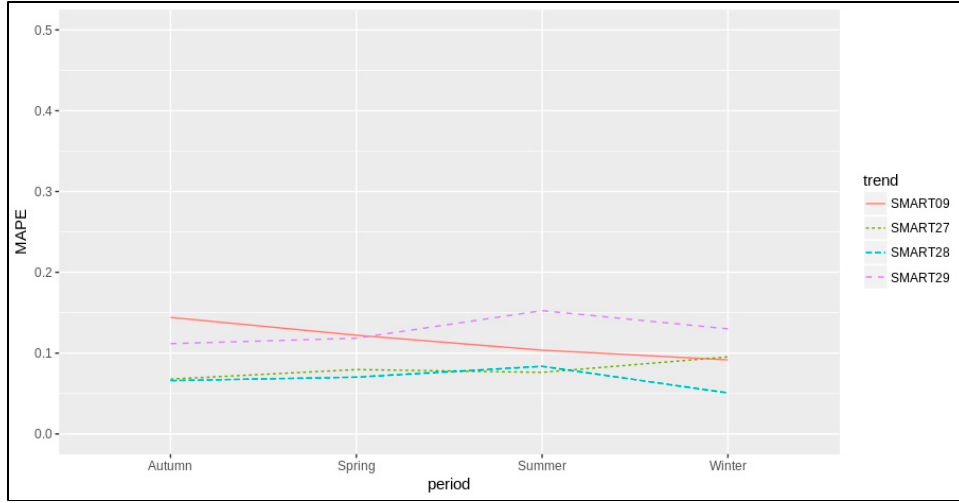
Figure 9. Multilinear regression model results in terms of MAPE according to each sensor location and each period of the year. The results were obtained during the peak traffic periods when uncongested and congested traffic situations arise and significant CO 2 emissions occur.